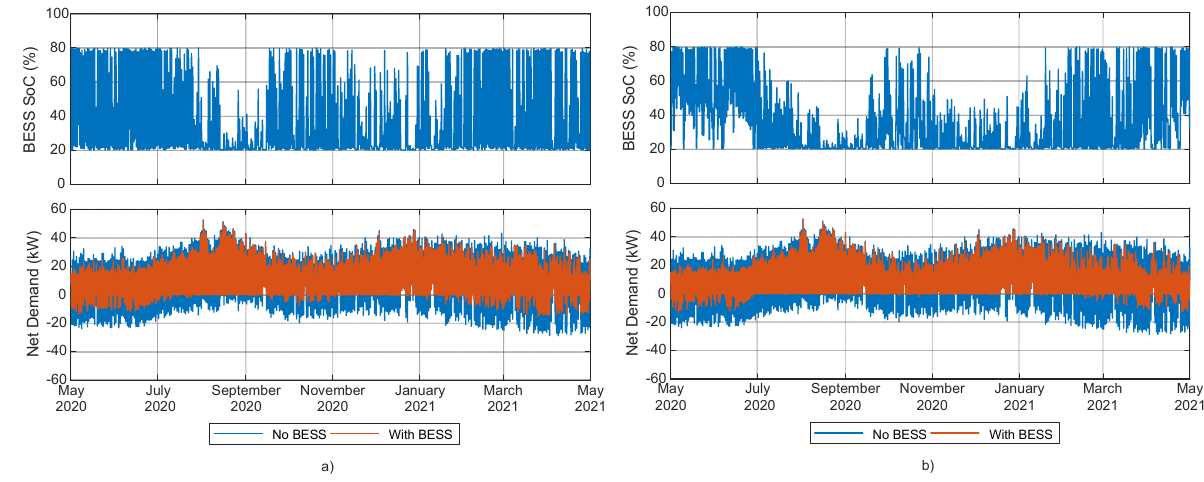
Figure 9. Net demand with and without storage and daily variations in the State of Charge for EC1. ( a ) With a 57 kWh BESS. ( b ) With a 114 kWh BESS.